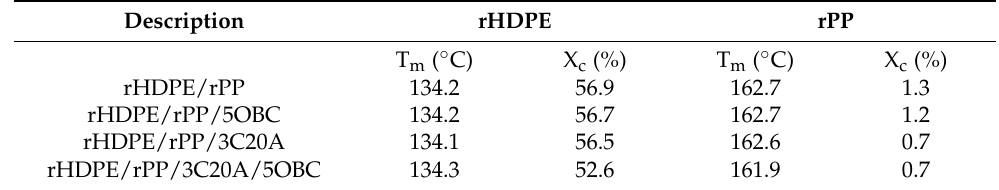
Table 3. Melting temperature (T m ) and percentage of crystallinity (% X c ) of the rHDPE/rPP composites.